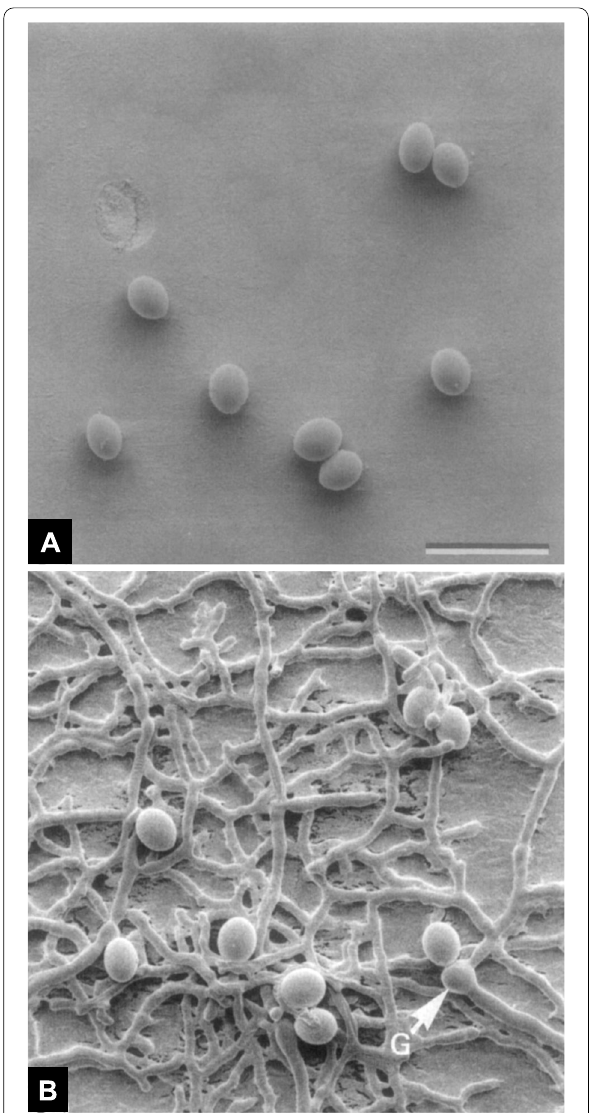
Fig. 3 Cryo-scanning electron micrographs of the same ascospores of a fungus Sordaria macrospora . A Before germination. Bar 50 μm. = B After germination. G germination vesicle (Read and Lord 1991 5 μm = = with permission from the